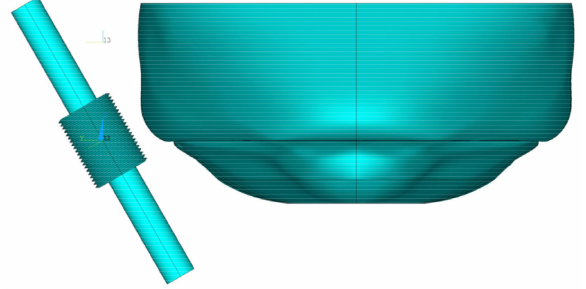
Figure 26. The FE model of side collision between the ship and the pipe.